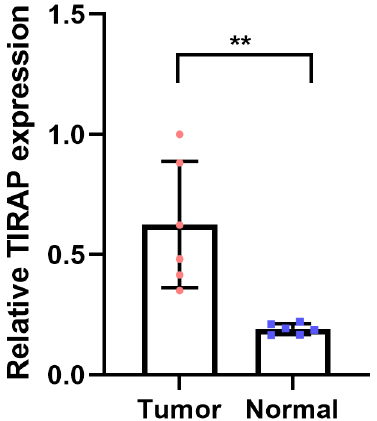
Figure 7. PCR was performed to verify the expression of TIRAP (** p < 0.01).